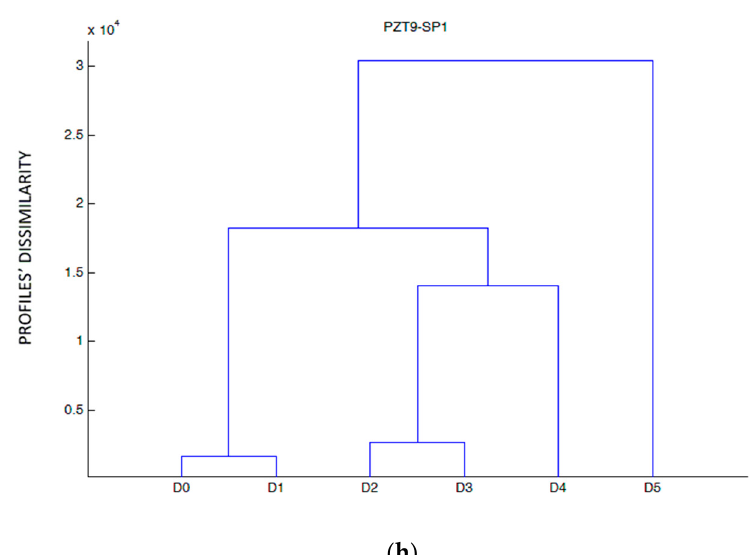
Figure 10. Hierarchical trees for specimen A. ( a ) Sensor PZT1, ( b ) Sensor PZT2, ( c ) Sensor PZT3, ( d )